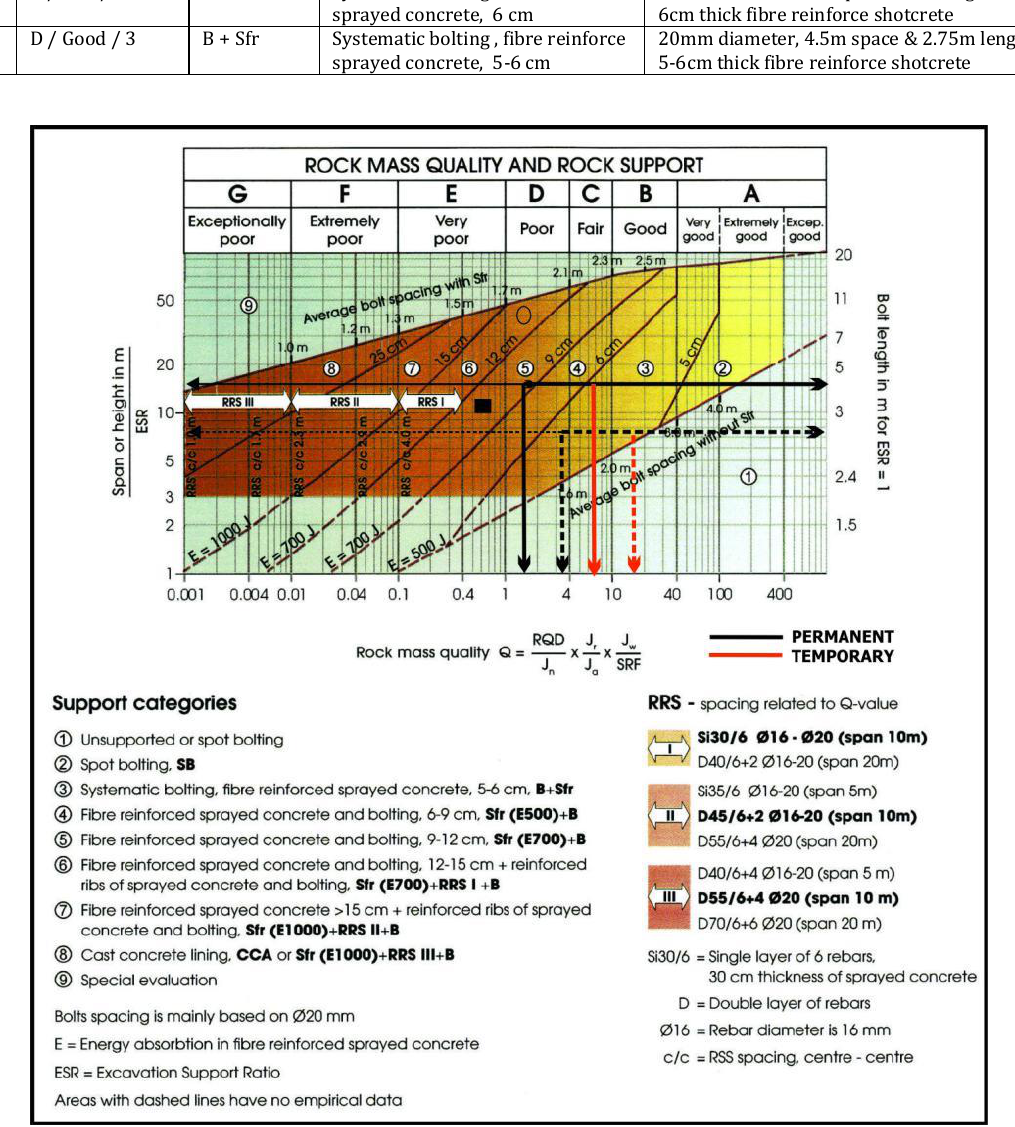
Figure 2: Lines of the result of Q-value and permanent and temporary support design requirement of tunnel roof (solid lines) and wall (dot lines) The permanent support on the roof are 20mm diameter, 2.5m space and 4 length bolts and 9-12 cm thick and 700J energy absorption of fiber reinforce sprayed concrete as well as 20mm diameter, 4m space and 2.75m length and 6-9 cm thick fiber reinforce shotcrete for the wall [13]. The temporary support for the roof is 20mm diameter, 4m space and 4m length bolts and 6cm thick fiber reinforce shotcrete but 20mm diameter, 4.5m space and 2.75m length bolts and 5-6cm thick fiber reinforce shotcrete in the wall, respectively. The support pressure for proposed tunnel roof (P roof ) is